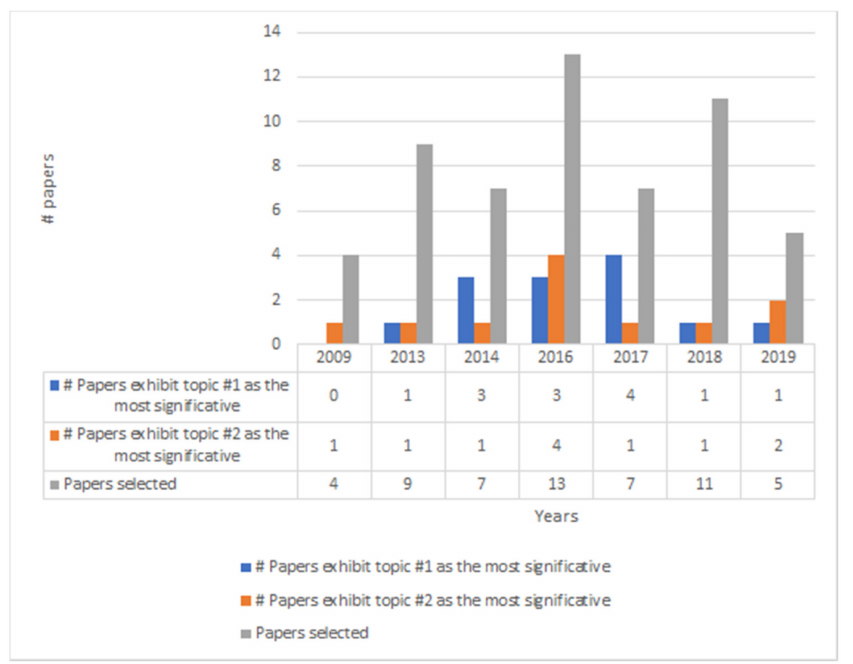
Figure 6. Distribution of the papers belonging to Topic 1 and Topic 2 over the years with respect to the total number of